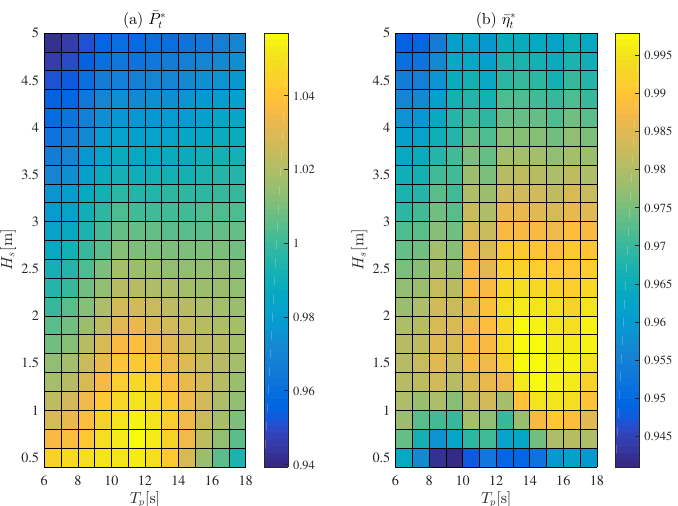
Figure 13. Time averaged results of the i-MET controller under the PM irregular wave model with various T p and H s for T m = 5000 s: ( a ) relative power extraction from turbine; ( b ) relative average turbine efficiency.